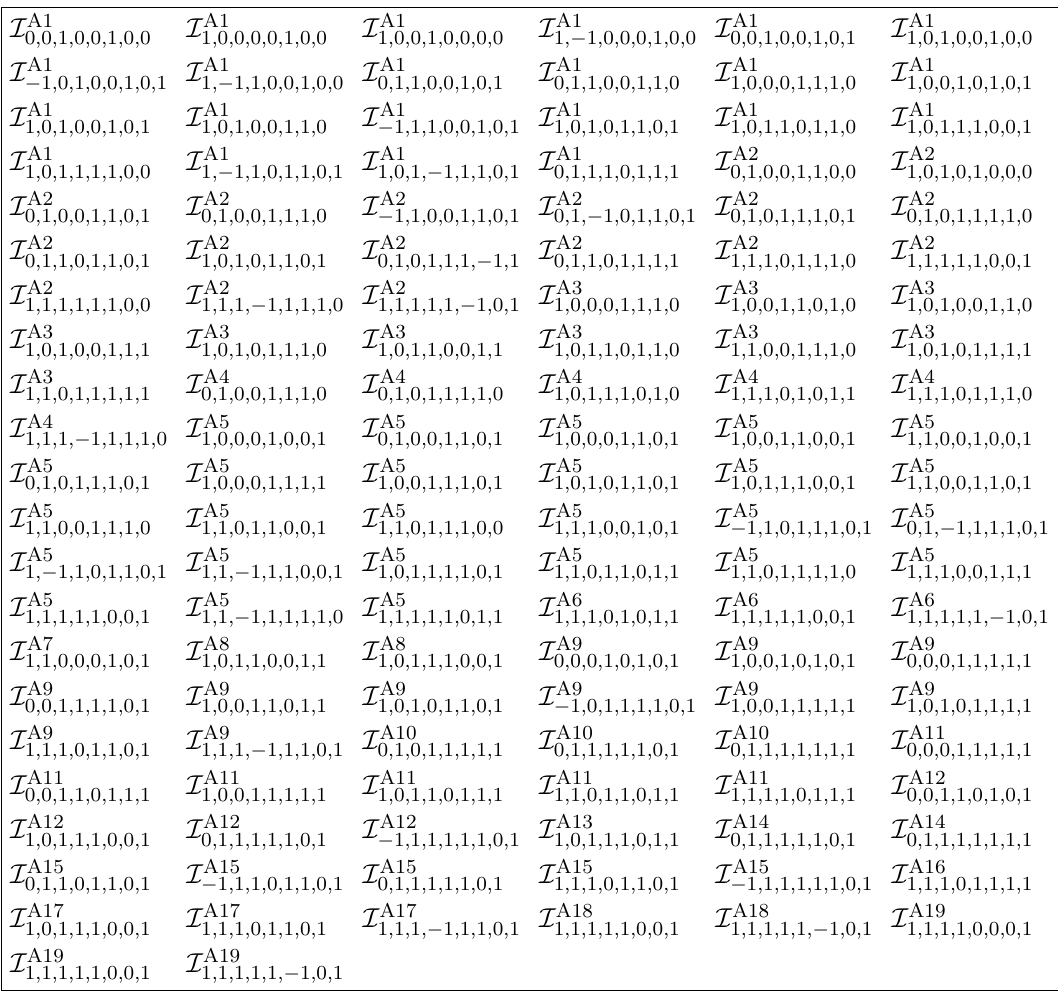
Table 2 . The set of 128 master integrals for the matching coe(cid:14)cients of the double-real contribution to the quark beam